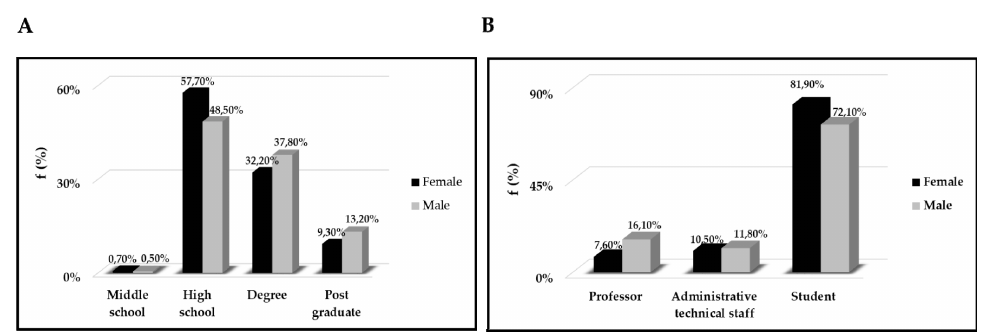
Figure 1. ( A ) Representation of the educational level of the population examined. On the y-axis we reported the frequency as a percentage (%) respect to stratification by gender, and on the x-axis. The degree of education. ( B ) Stratification according to gender of the role covered within the university of the population examined. On the y-axis we reported the frequency as a percentage (%) respect to stratification by gender, and on the x-axis. The job